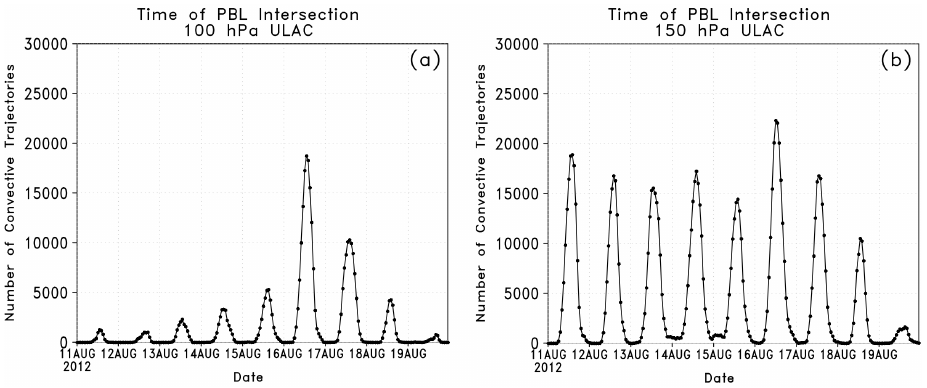
Fig. 8. The number of convective trajectories starting at 100hPa (a) and 150hPa (b) , and the time (UTC) at which they crossed the PBLH during the runtime. Table 1. Results from the 15 min forward-trajectory analysis for each region in Fig. 7. Region Total trajectories Convective trajectories Average W Maximum W TP 5046336 239251 (4.7%) 8ms − 1 17ms − 1 SS 3127224 51382 (1.6%) 9ms − 1 23ms − 1 BOB 2004096 25448 (1.3%) 9ms − 1 21ms − 1 IND 3695184 4449 (0.1%) 10ms − 1 20ms −